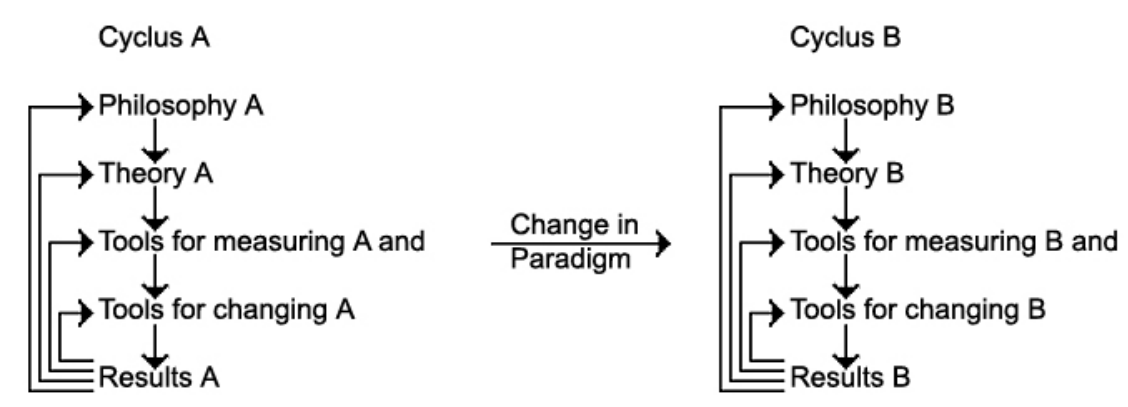
FIGURE 1. To measure the impossible — a new and unexplored area of reality (A) — takes understanding expressed as philosophy of A, new theory of A derived from the philosophy, new tools for measuring A, changing A derived from the theory, and results produced by the use of the combined tools, giving feedback to all levels above. While the results will confirm the correctness of the philosophy and theory for the normal researcher, ignoring the anomalies of the research, the same results and anomalies will lead the pioneer